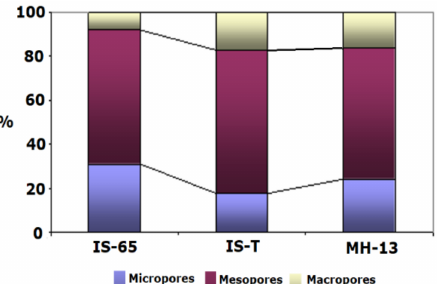
Figure 2. Percentage distribution of surface pores in the range of micro, meso, and macro for IS-65, IS-T, and MH-13